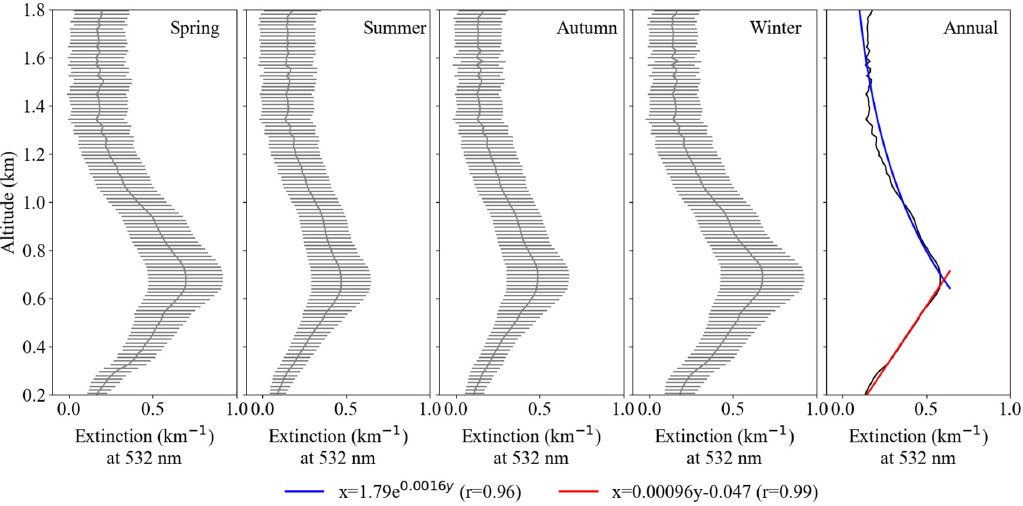
Figure 5. Seasonal and yearly mean aerosol vertical extinction profiles at the site of Southwest Jiao-tong University.